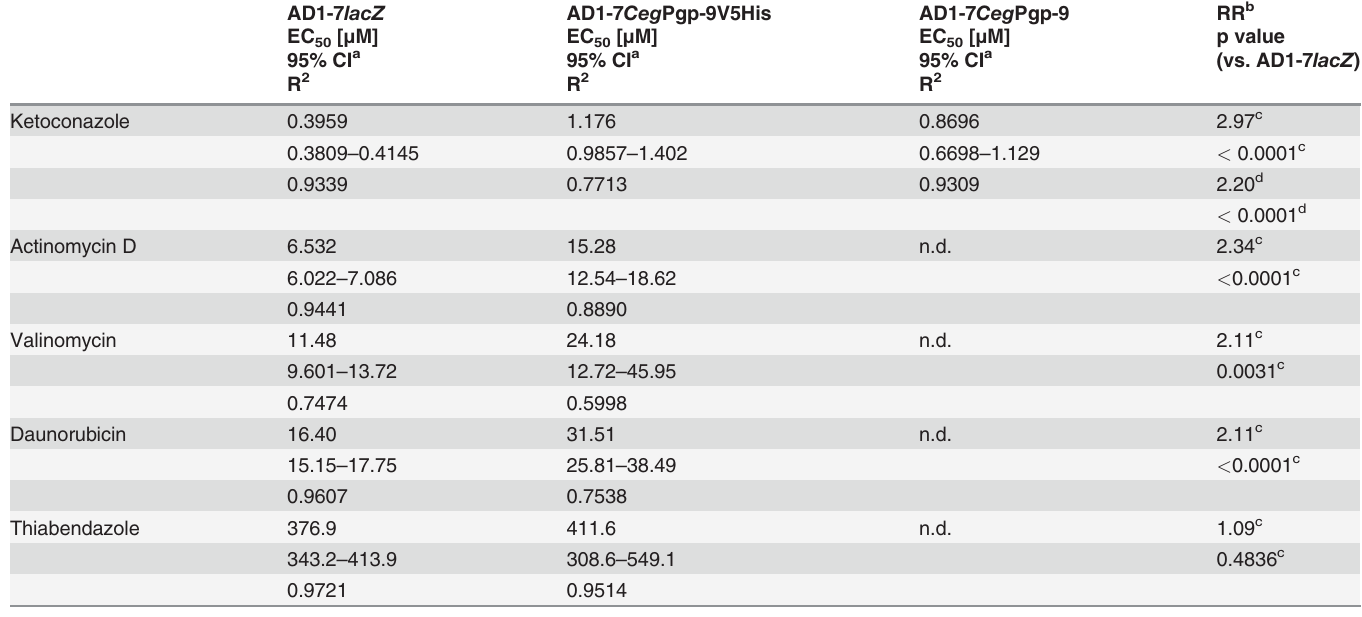
Table 1. EC 50 values of AD1-7 yeast strains with or without expression of C . elongatus